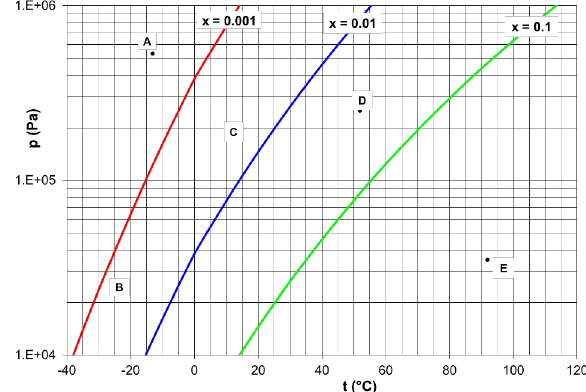
Fig. 3. Saturation lines in p − t diagram for the moist air and dif- ferent values of specific humidity x . Di ff erent states are marked and its quality is described in Table 1